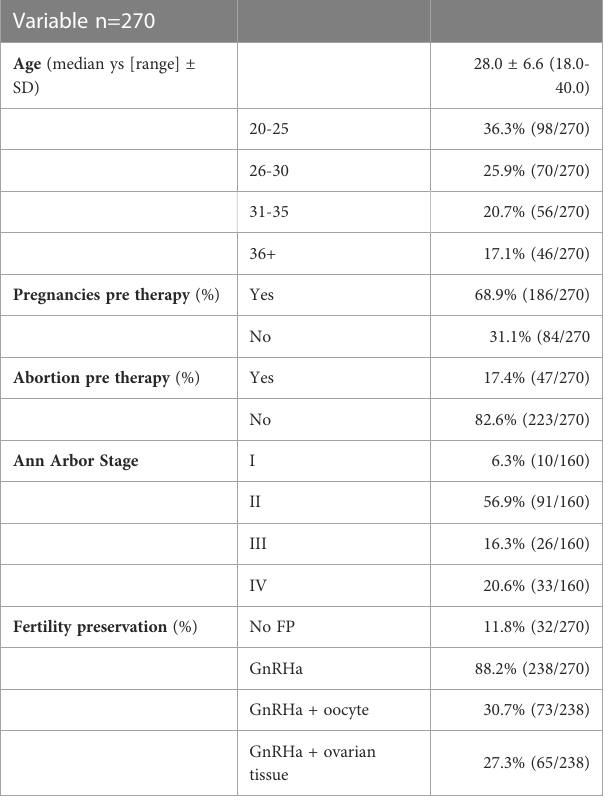
TABLE 1 Demographic and FP characteristics of patients.